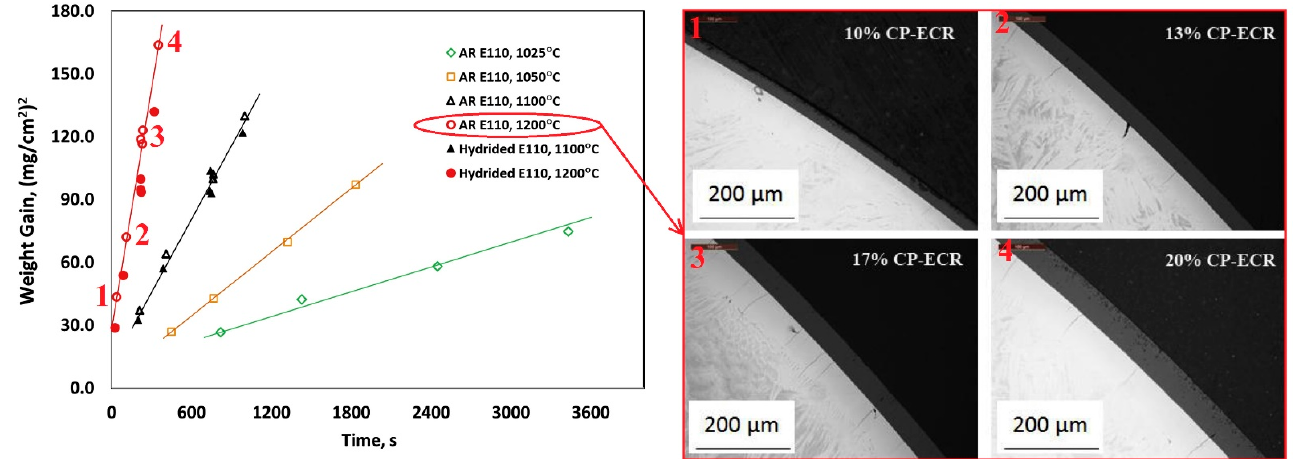
Figure 1. Parabolic oxidation curves of sponge-based E110 alloy in steam at 1025–1200 °C (left), and cross-section optical micrographs of the alloy after 1200 °C steam oxidation to 10%, 13%, 17% and 20% ECR (CP—Cathcart–Pawal, ECR— equivalent cladding reacted, AR—as-received). Reproduced from [58] with permission by Elsevier.